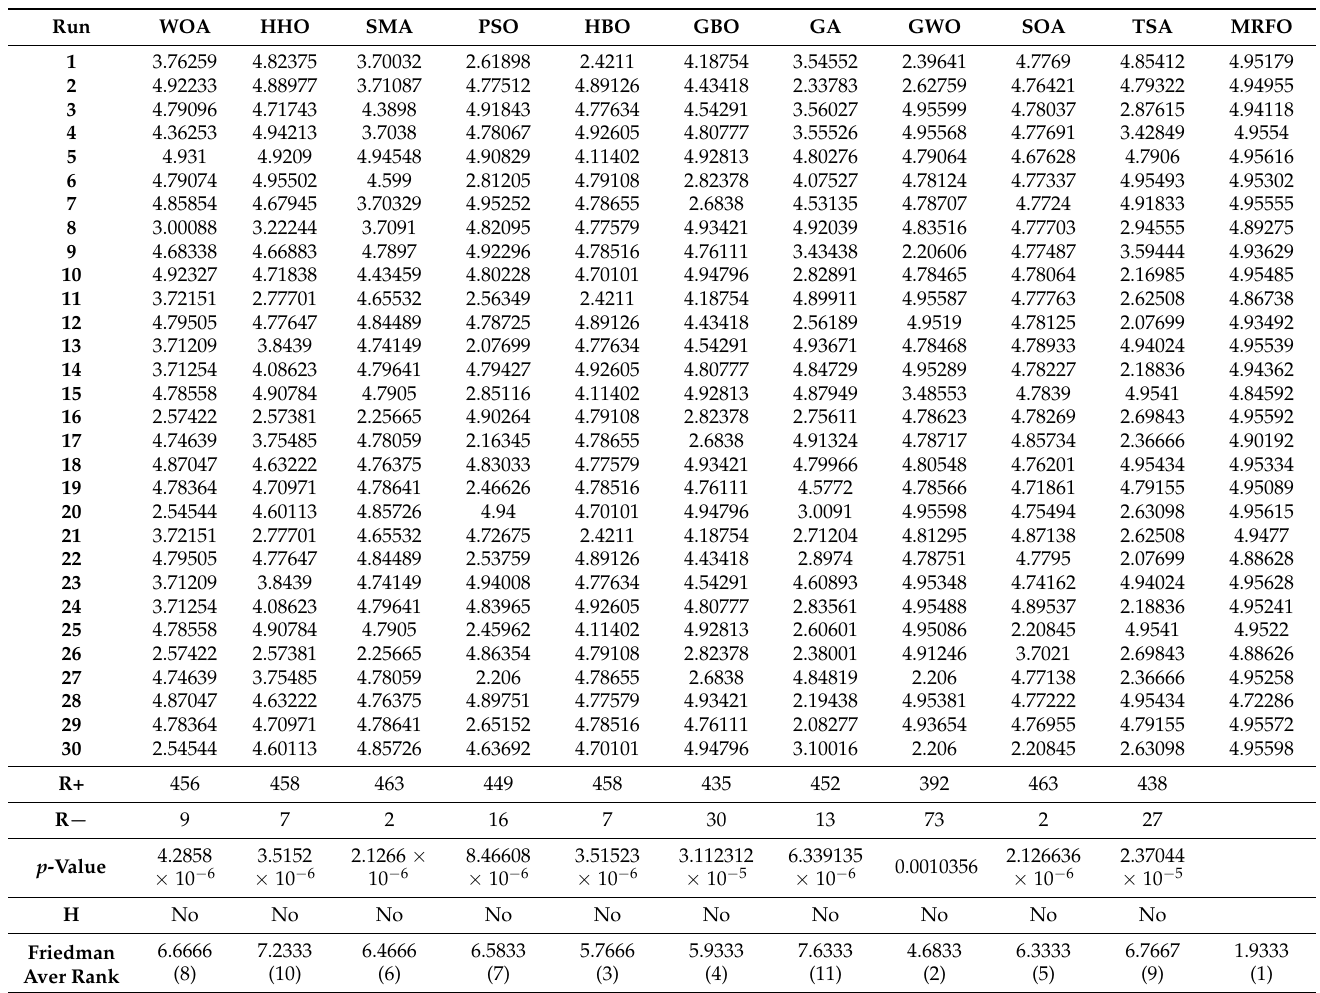
Table 2. Details of 30 runs using different